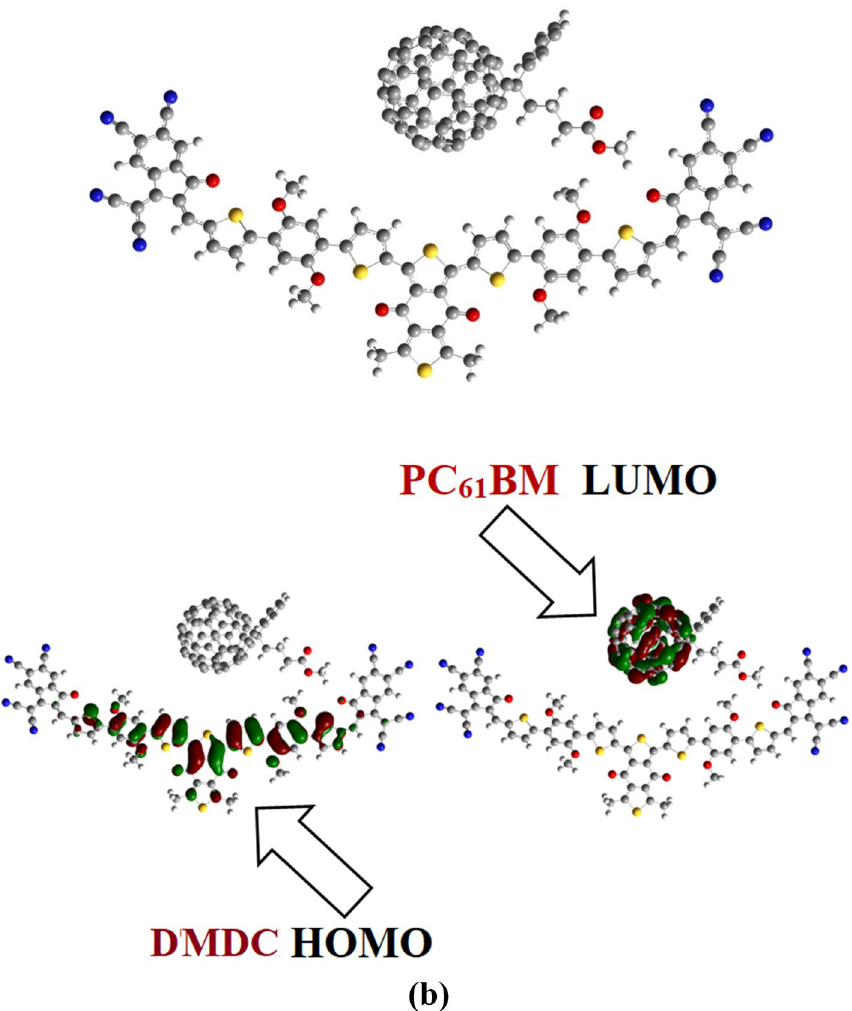
Figure 8. Graphical representation of optimized geometry of DMDC: PC 61 BM and Charge transfer between HOMO donor to LUMO PC61BM .These exhibits are prepared with the help of GaussView 5.0 and Gaussian 09 version D.01 (https:// gauss ian. com/ g09ci